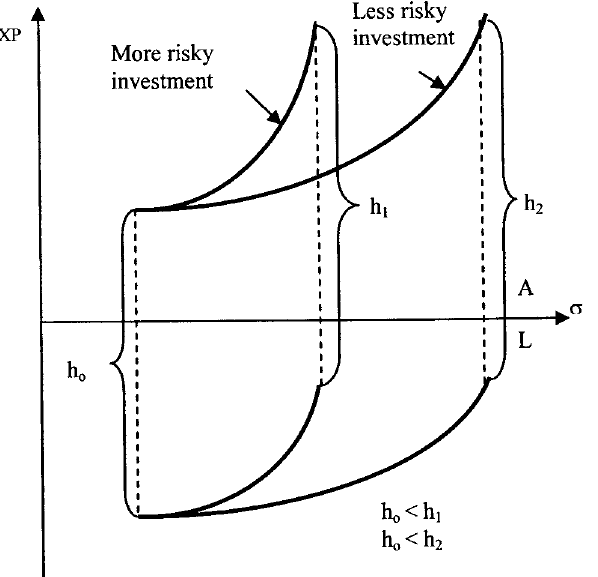
Fig 1 . The differences in the tendency of relation between cash flow variance ( σ ) and expected value (EXP) for assets (semi plane A) and liabilities (semi plane